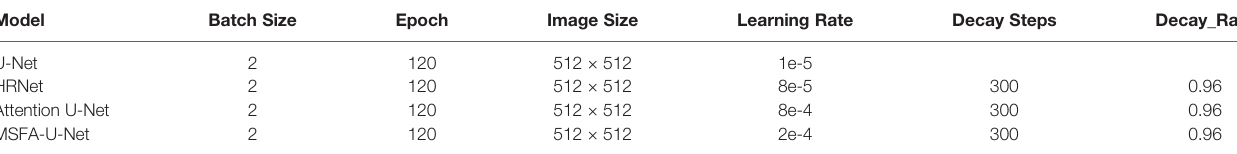
TABLE 1 | Network training parameters. Model Batch Size Epoch Image Size Learning